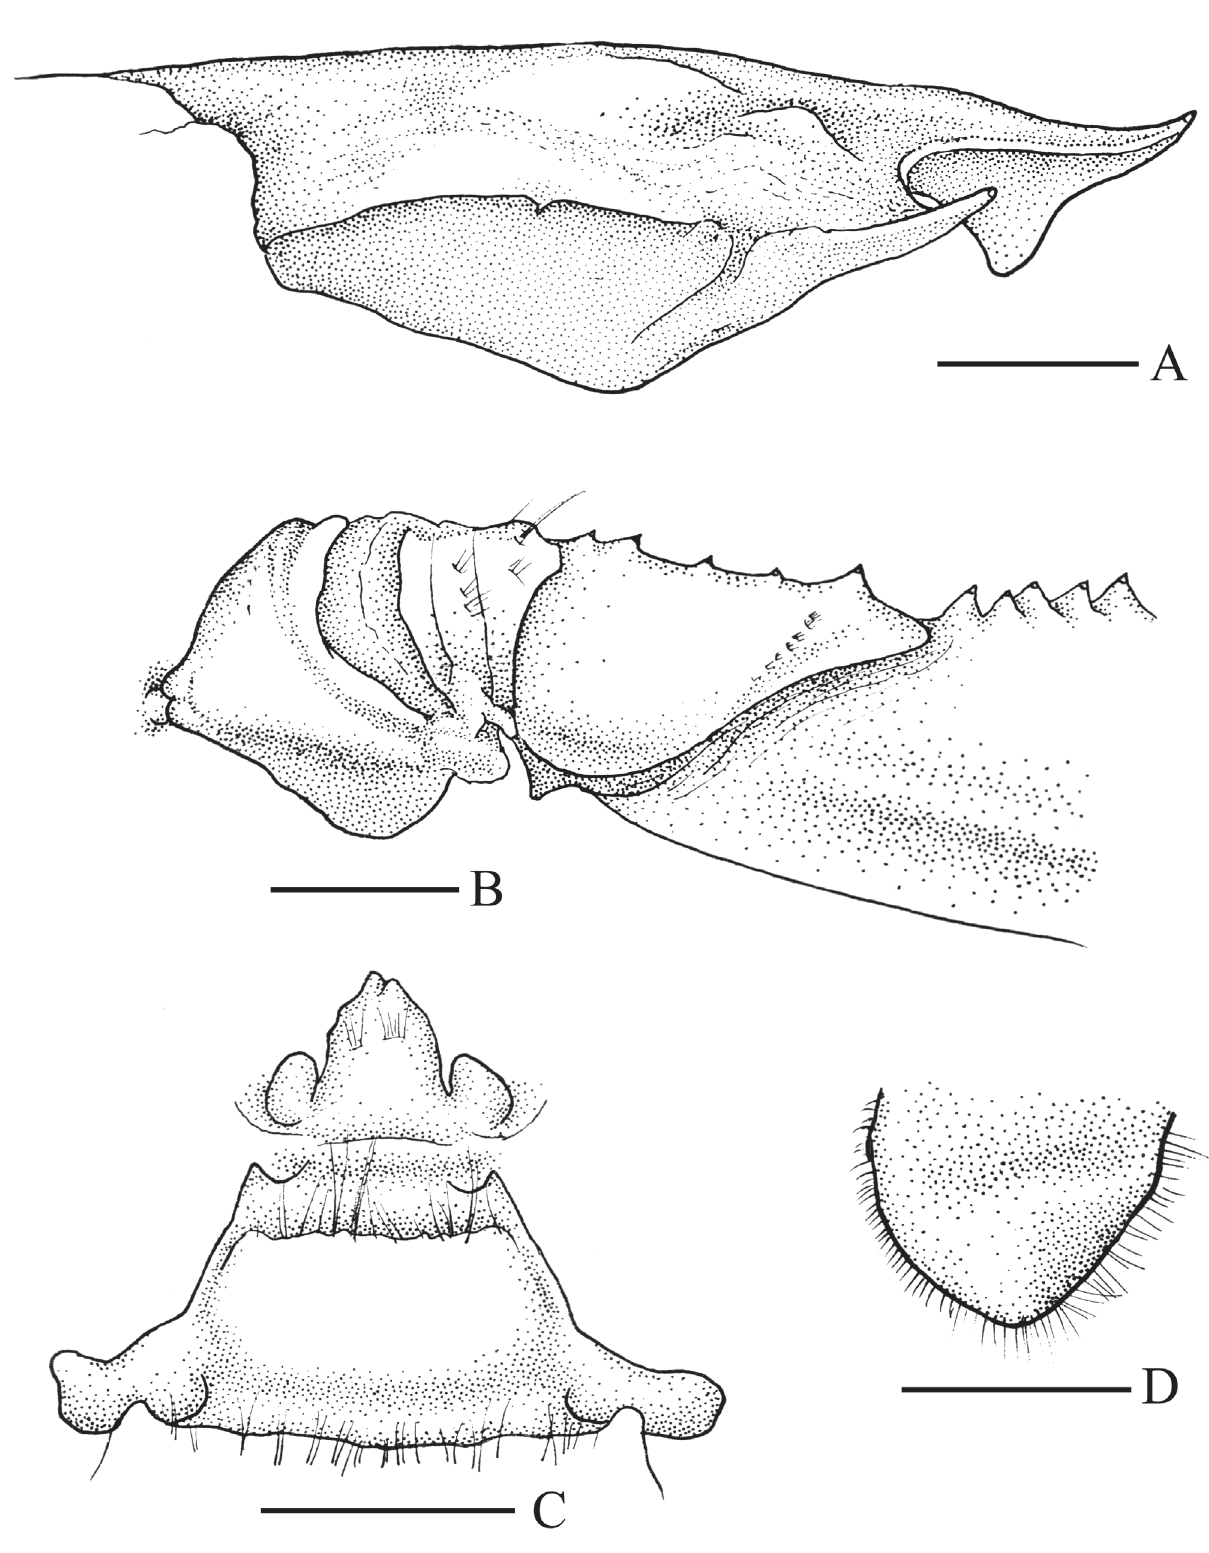
Figure 7. Aegla charon n. sp., male, holotype (MZUSP 35193). A) Lateral view of anterior region of carapace; B, Coxa, basi-ischium and merus (part); C, Third (in top position) and fourth sternites; D, Second pleonal epimeron. Scale bars = 2.5